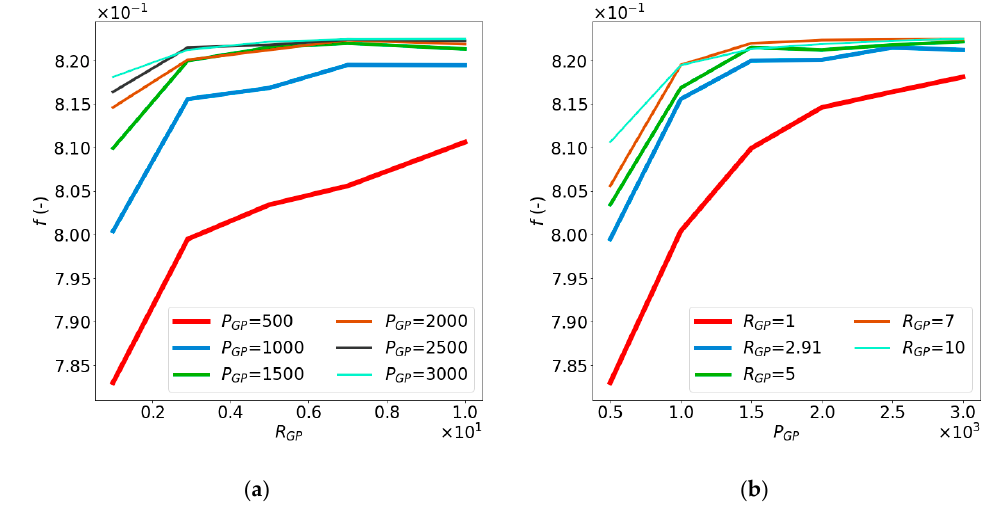
Figure 13. Result of the sensitivity study of the fitness to the R GP ( a ) and P GP ( b ).